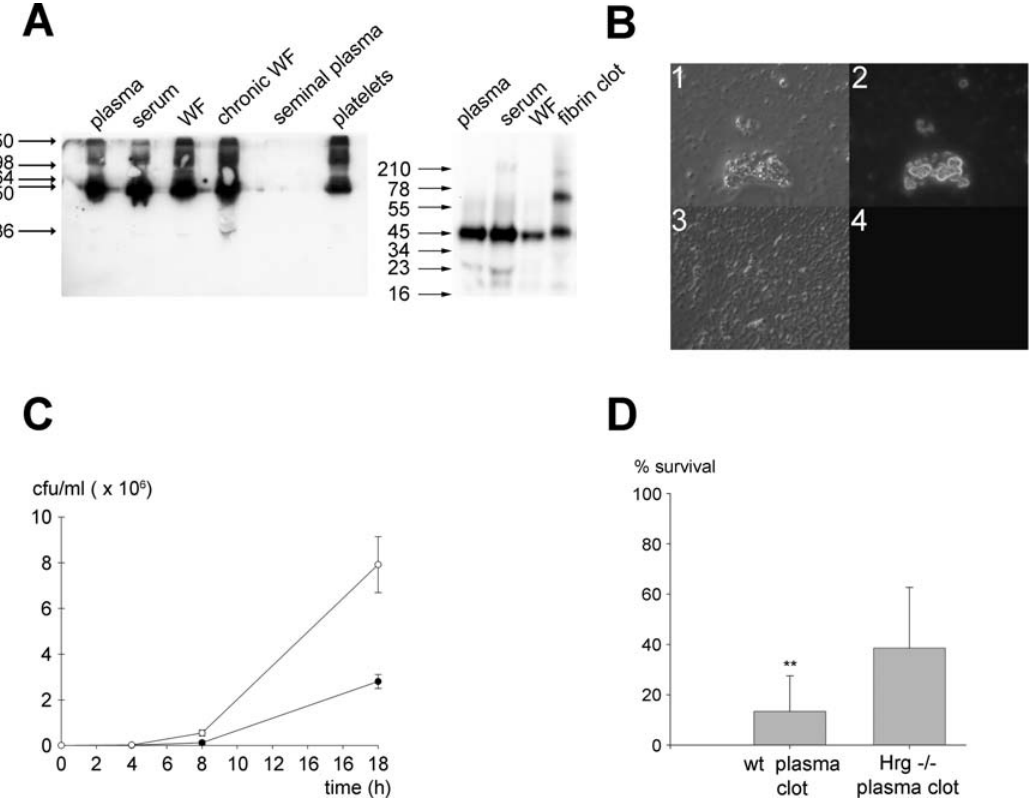
Figure 5. Localization and activities of HRG. ( A ) Analysis of HRG in biological fluids. The indicated biological materials were electrophoresed on a 8% gel (Tris-Glycine, non-reducing conditions) (left panel) or on a 16.5% Tris-Tricine gel under reducing conditions (right panel) and transferred to a nitrocellulose membrane. Western blot was performed using polyclonal antibodies directed against the GHH20 epitope of HRG. ( B ) Localization of HRG in fibrin clots. Human control plasma (panel 4) or plasma depleted of HRG (panel 2) were incubated with FITC-labeled HRG and clots were generated overnight after addition of 10 mM Ca 2 + at 37 u C. The clots were mounted on slides and visualized by fluorescence microscopy. The left side shows Nomarski images (1 and 3), whereas the right part shows fluorescence of HRG associated with the clots. ( C ) Candida growth in plasma. C. parapsilosis (2 6 10 7 cfu) was inoculated in human plasma ( N ) or human HRG-deficient plasma ( # ) and incubated at 27 u C for 0, 4 ,8 or 18 hours and the number of cfu was determined (n=6). ( D ) Antifungal activity of HRG ex vivo. Mouse control plasma or plasma of Hrg 2 / 2 mice were used to form fibrin clots in the presence of 10 mM Ca 2 + . Clots were incubated with C. parapsilosis ATCC 90018 (1 6 10 5 cfu) in 10 mM MES, pH 5.5 for 2 hours, plated and the number of cfu determined (p=0.043, n=6).